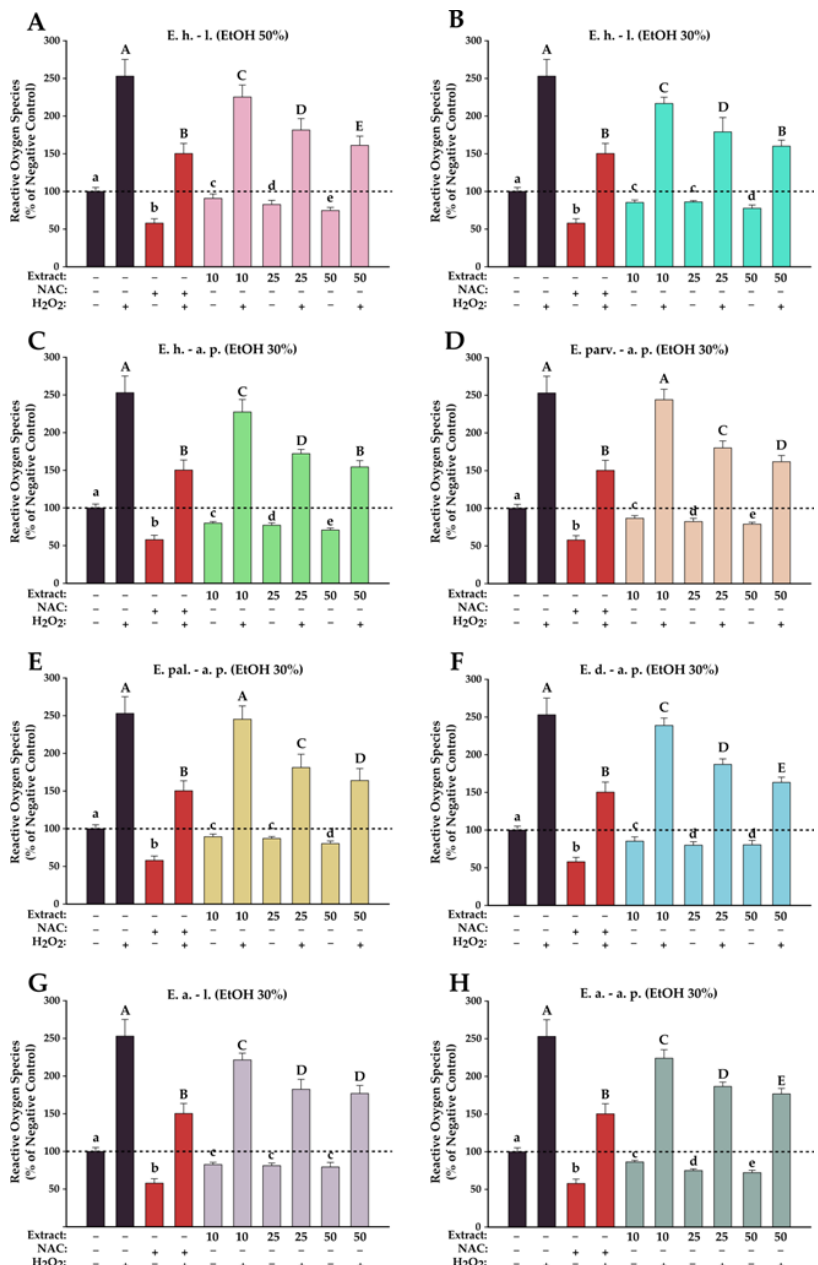
Figure 6. Antioxidant effects of E. hirsutum leaves EtOH 50% (A - E. h. – l.), E. hirsutum leaves EtOH 30% (B – E. h. – l.), E. hirsutum aerial parts EtOH 30% (C – E. h. – a.p.), E. parviflorum aerial parts EtOH 30% (D – E. parv. – a. p.), E. palustre aerial parts EtOH 30% (E – E. pal. – a. p.), E. dodonaei aerial parts EtOH 30% (F – E. d. – a. p.), E. angustifolium leaves EtOH 30% (G – E. a. – l.), and E. angustifolium aerial parts EtOH 30% (H – E. a. – a. p.) evaluated using DCFH-DA assay on normal BJ human foreskin fibroblasts cell line. Cells were incubated with the extracts (10, 25, and 50 µg/mL) or NAC (20 mM) for 24 h and further exposed to 50 µM DCFH-DA. The antioxidant potential was measured in stimulated/non-stimulated conditions after a 2 h exposure in the presence and absence of 250 µM H 2 O 2 . Data are presented as relative means ± standard deviation of three biological replicates. All values are expressed as relative values compared to the negative control (100%). Different letters (a-e in non-stimulated conditions, and A-E in stimulated conditions) show statistically significant differences (ANOVA + Holm-Sidak post hoc test at p<0.05 )